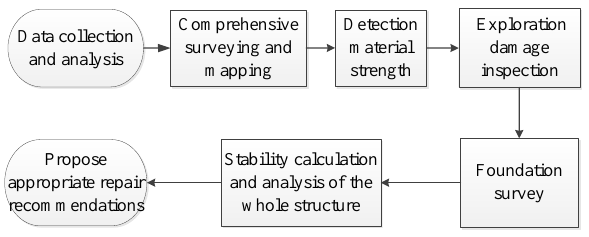
Figure 1. Detecting operation flowchart